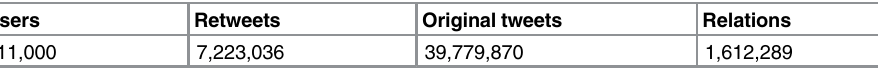
Table 1. Dataset Statistics.